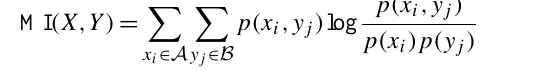
Fig. 12. Comparison between the seasonal dependence of the 1996 quiet daily variation along the H component as reconstructed us- ing contribution from the 2nd and 4th EOF ( S H q = A 2 (negative and positive values are in red and blue, respectively) and the true S q (black circles) evaluated by averaging the daily variation of the 5 quietest days of every month of 1996. Time is reported in universal time (UT = LT − 1) for